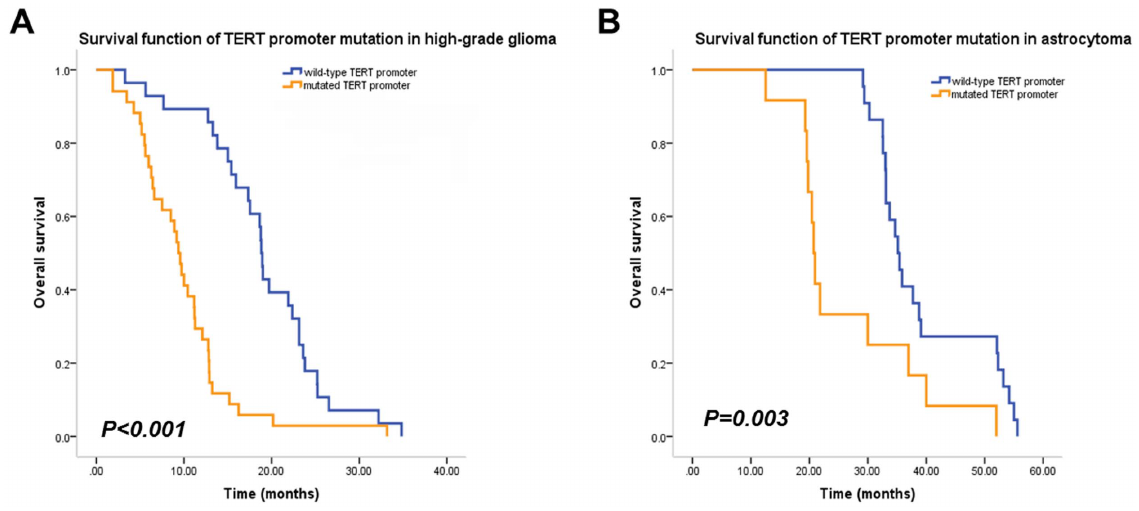
Figure 2. Survival function of TERT promoter mutation in glioma patients. A: Kaplan-Meier analysis showing the OS of high-grade glioma patients with wild-type (blue line) and mutated (orange line) TERT promoters. The difference in OS was significant between the two groups. B: Kaplan-Meier analysis showing the overall survival (OS) of low-grade glioma ( i.e. , astrocytoma) patients with wild-type (blue line) and mutated (orange line) TERT promoters. The difference in OS was significant between the two groups.